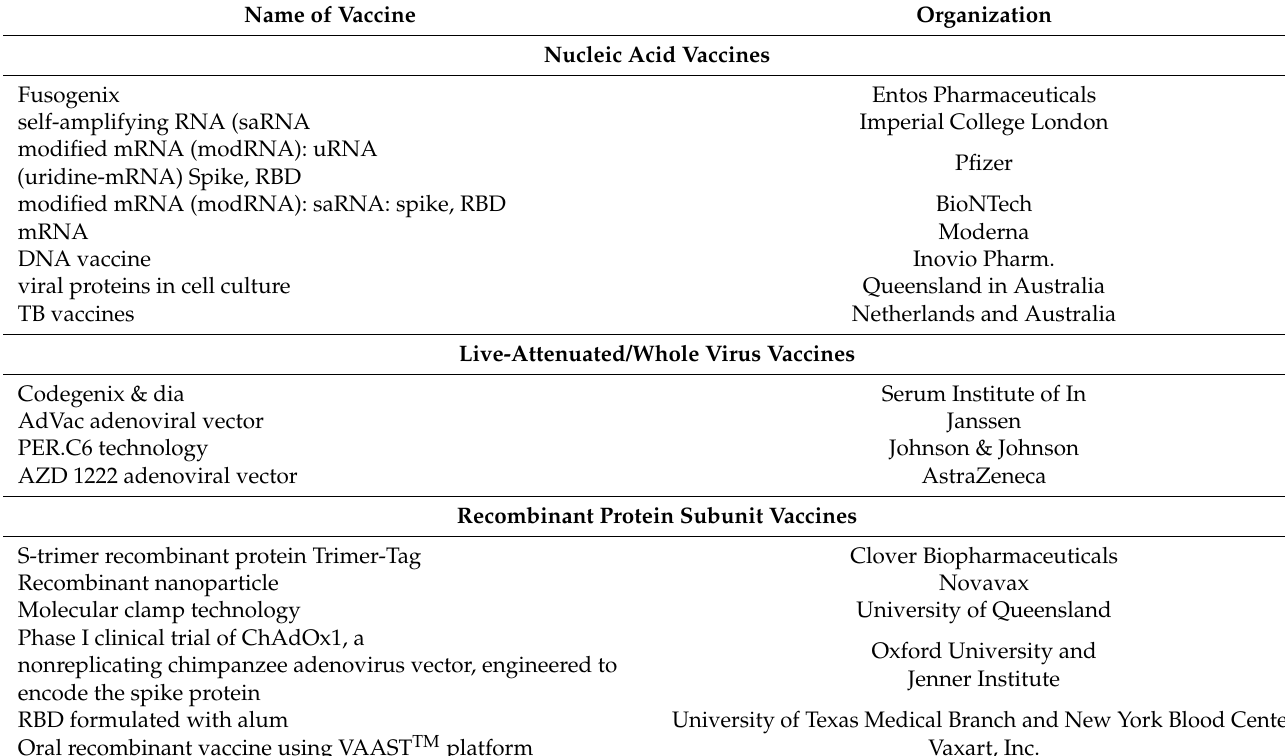
Table 1. Selection of SARS-CoV-2 vaccines authorized for use, as well as others in preclinical and clinical development, their intended applications and